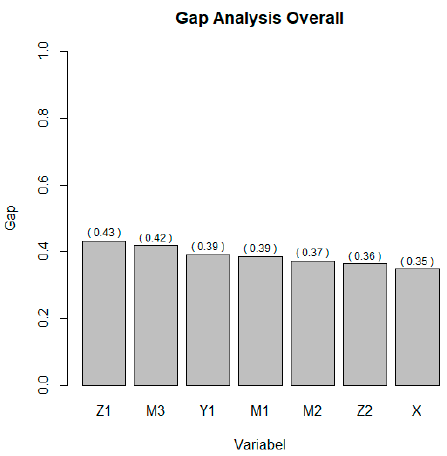
Figure A10. Bar Diagram of Gap Analysis of Blitar city.